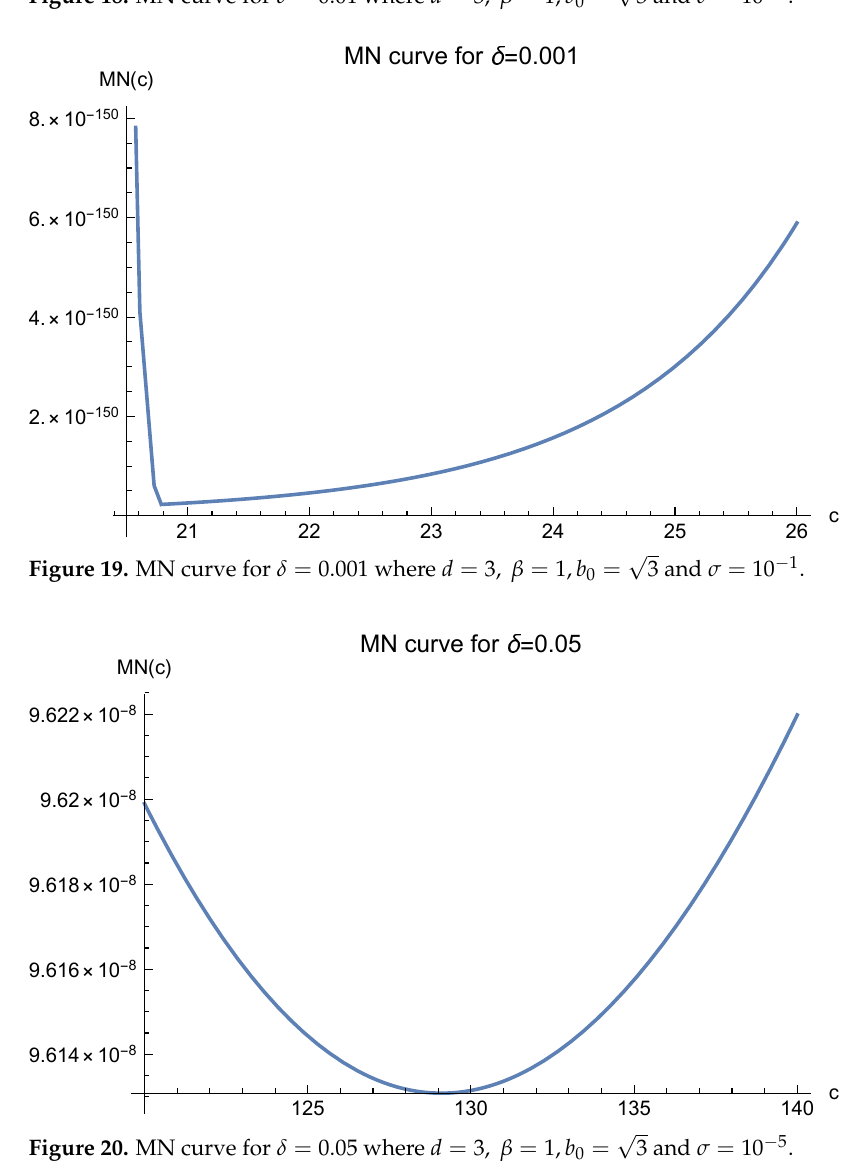
Figure 20. MN curve for δ = 0.05 where d = 3, β = 1, b 0 =